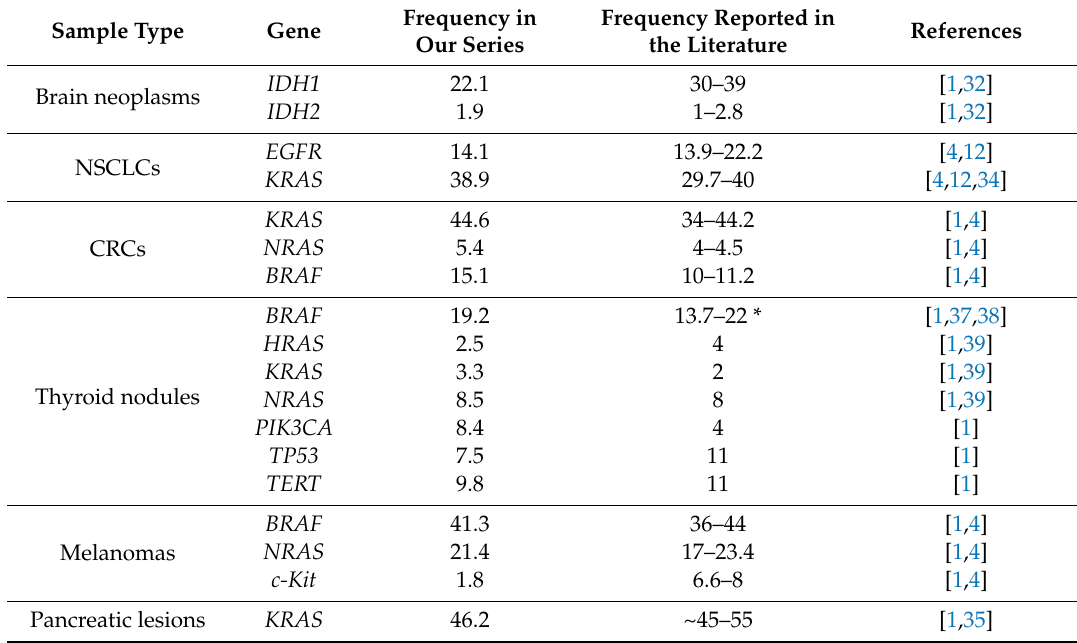
Table 5. Comparison of the custom-designed multi-gene panel mutational results with literature reference